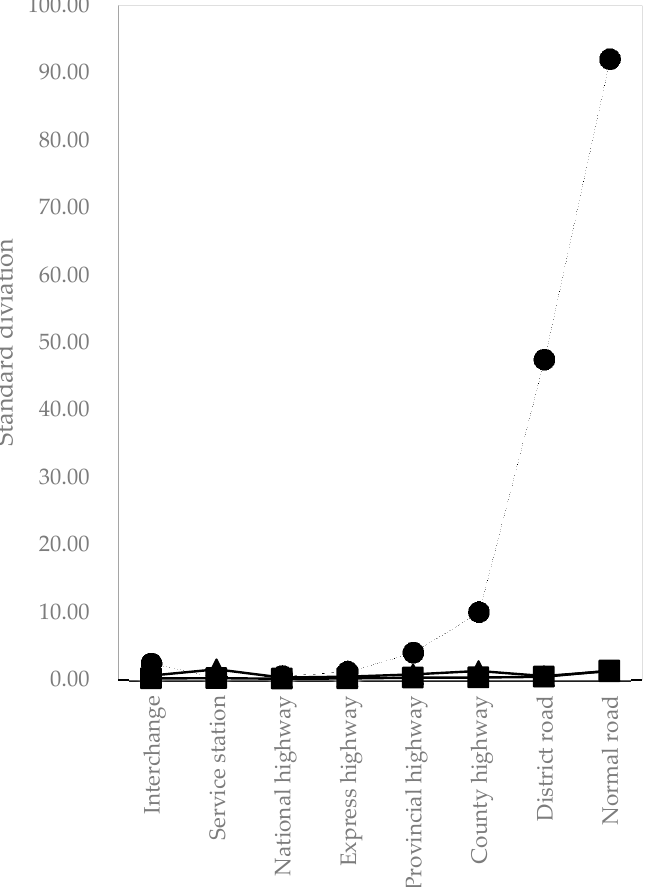
Figure 4. Standard deviations of three methods using 100000 samples with 50 runs.